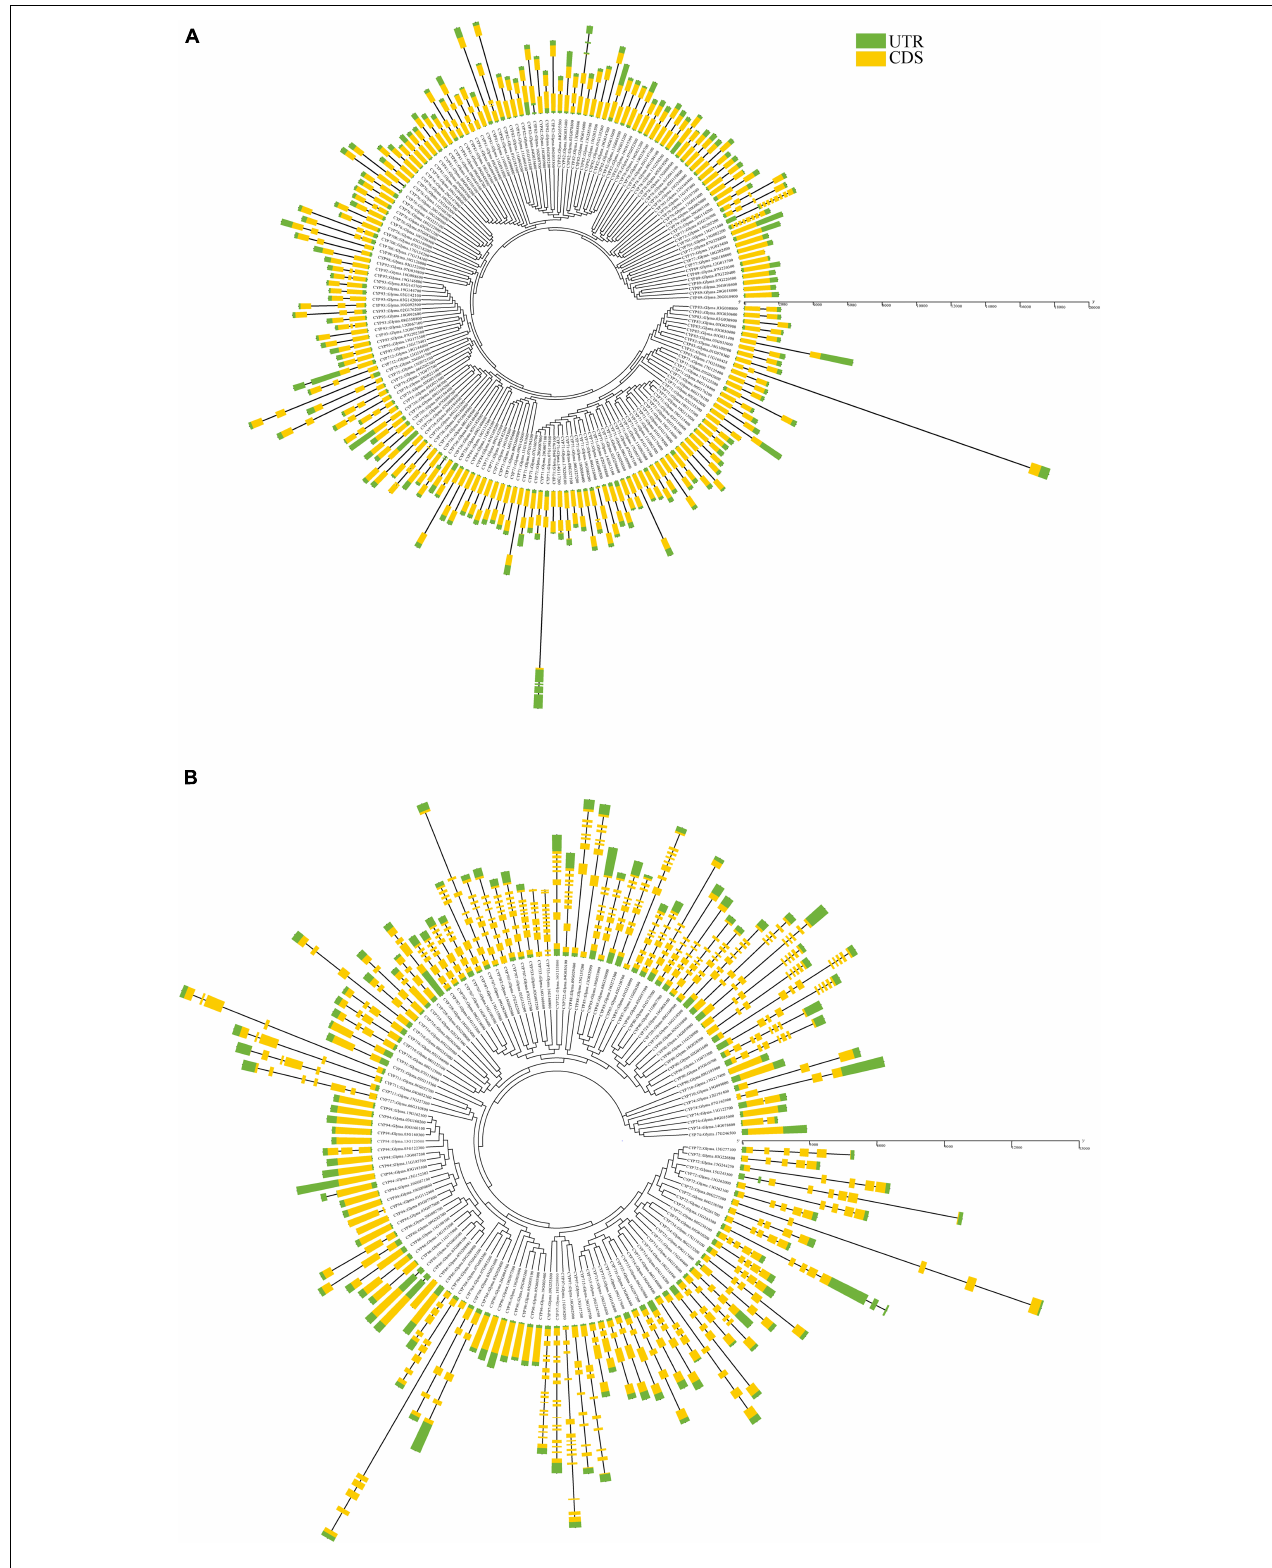
FIGURE 4 | Gene structure of all putative soybean P450s showing a distinct pattern of structure among (A) A-type, and (B) non-A-type GmP450s . Yellow regions and black lines represent exons and introns, respectively. Green regions indicate 5 (cid:48) or 3 (cid:48) untranslated regions. Scale bars in base pairs are shown.